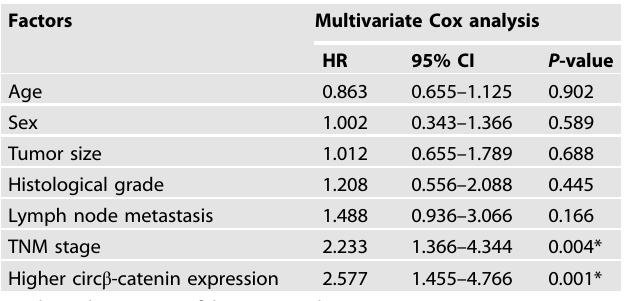
HR hazard ratio, CI con fi dence intervals. * P